Question: Express in one sentence what the figure is showing.
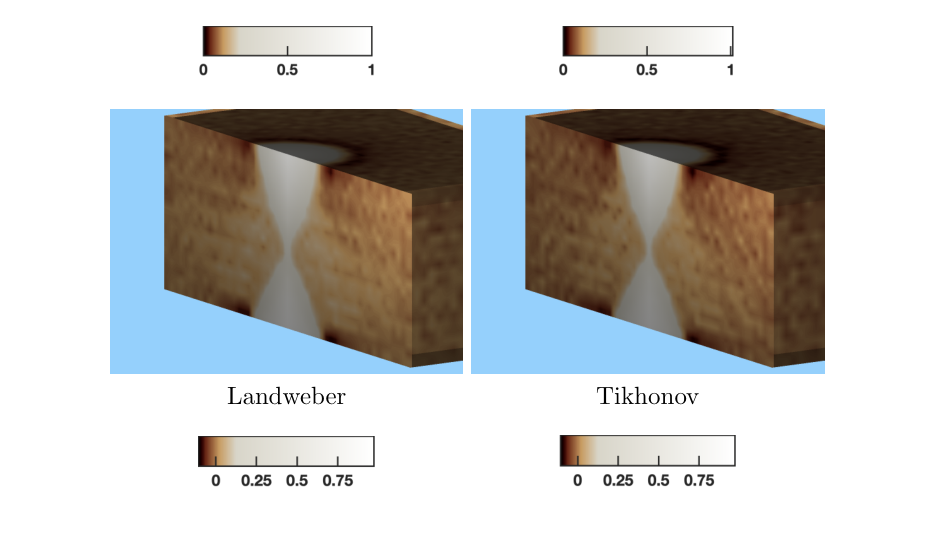
Answer: String reconstructions corresponding to lowest RRE for Example #2 via the considered methods for 5% noise with a = 1. The strings are sliced through the yt-plane to provide an interior viewpoint with the temporal direction of each of the strings increases from the bottom of figure to the top.